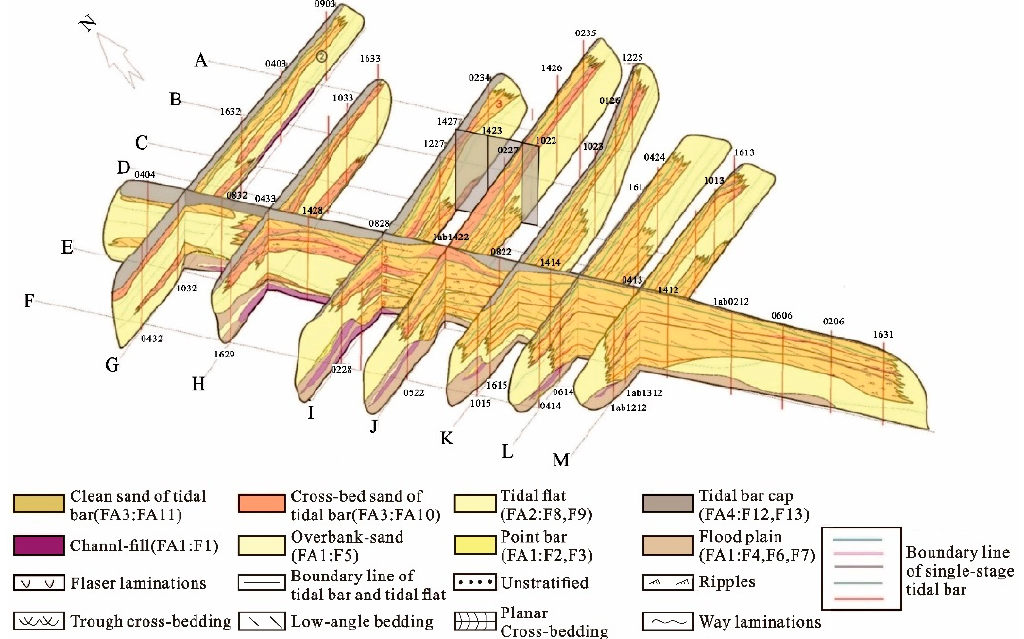
Figure 8. Axonometric drawing showing 3-D architecture of estuarine tidal bar deposits (The dark area show the location of Figure 7, (Since all well names have a prefix of “1AA” and a suffix of “09014W400”, so the well names are simplified by omitted by the prefix “1AA” and suffix “09014W400” in this figure).